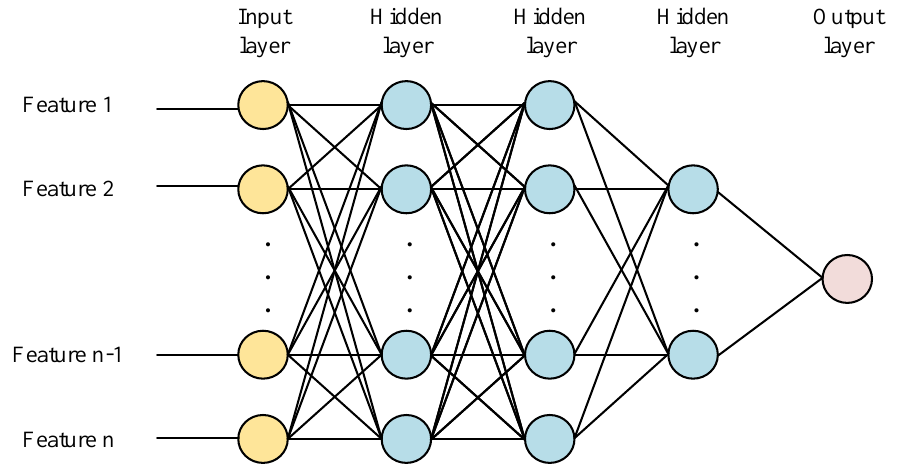
Figure 5. Structure of the multilayer perceptron.